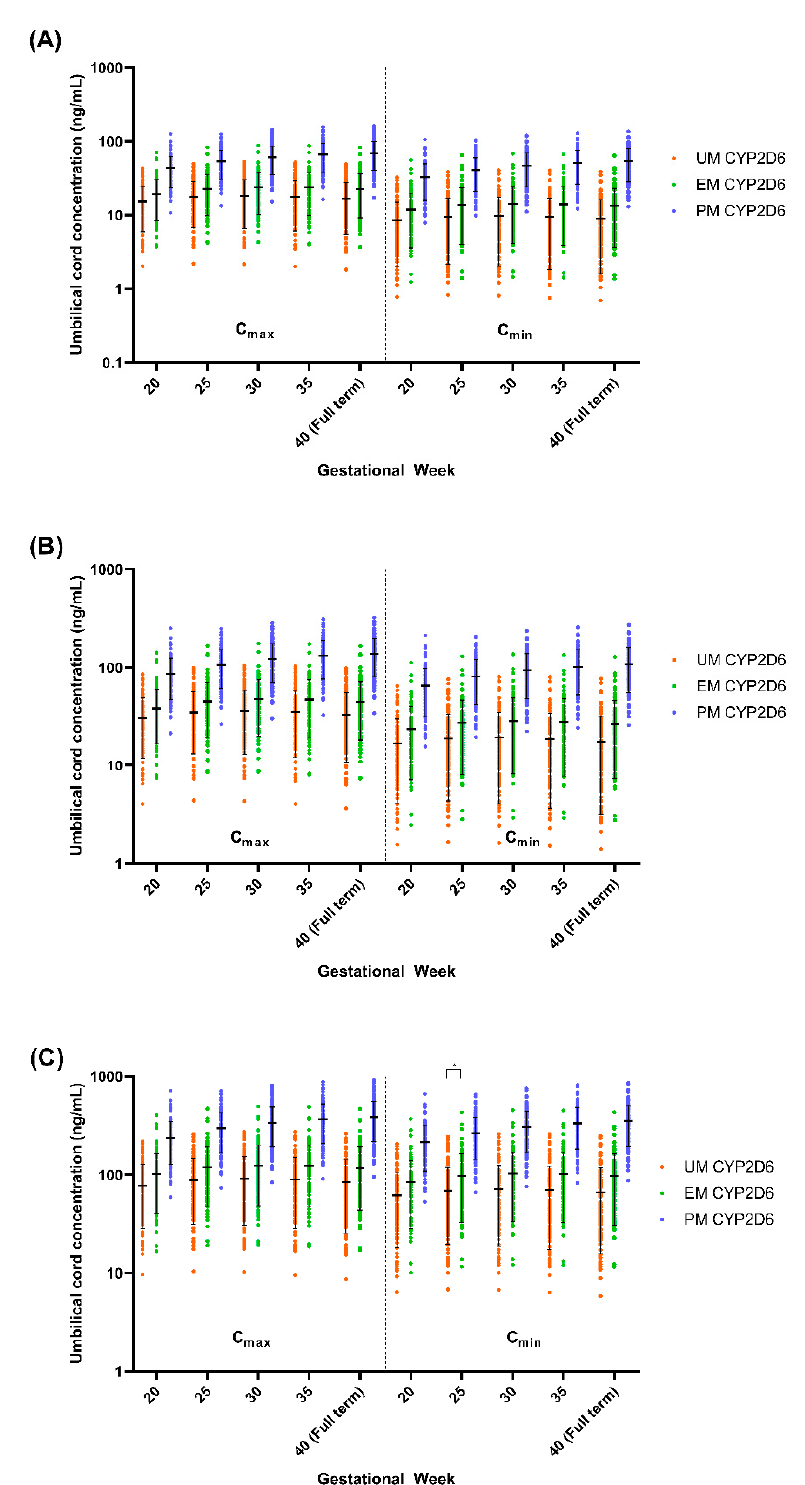
Figure 11. Simulated fluvoxamine umbilical cord concentrations in CYP2D6 phenotype population. ( A ) 50 mg daily; ( B ) 100 mg daily; ( C ) 300 mg daily. Coloured solid circles represent individual, predicted umbilical cord concentrations. C max , maximum concentration; C min , minimum concentration. Horizontal lines on the coloured solid circles represent mean and standard deviations. Comparing each CYP2D6 phenotype for every 5 GWs starting from GW 20 showed a statistically significant difference when compared with PM and a non-statistically significant difference between UM and EM at GW 25 for 300 mg daily—labelled as ‘*’; p <